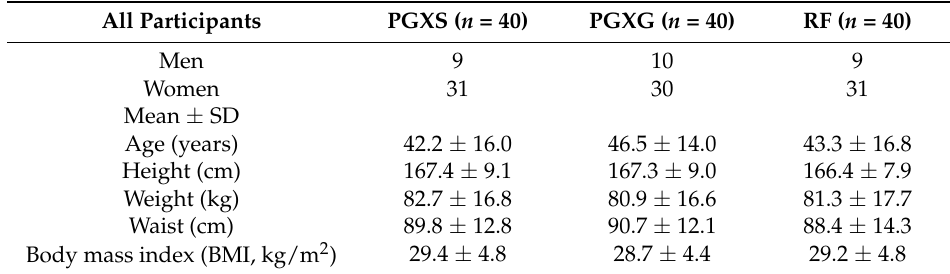
Table 1. Characteristics of all recruited study participants randomised at the baseline ( n = 120) comparing